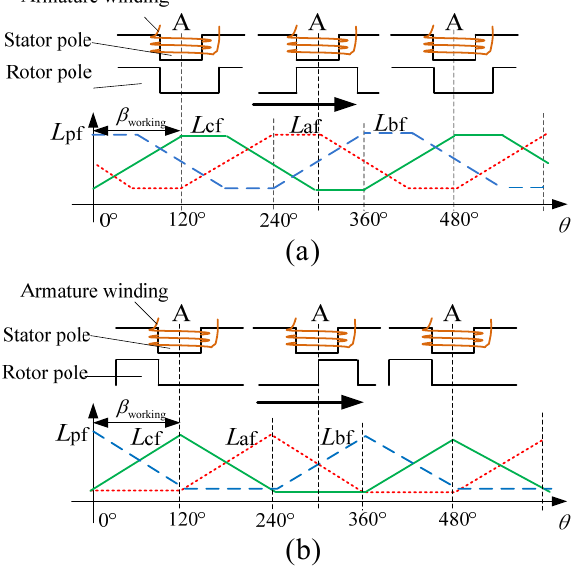
Figure 2. L pf of the three-phase WFDSM with different α r . ( a ) α r = 0.333; ( b ) α r =